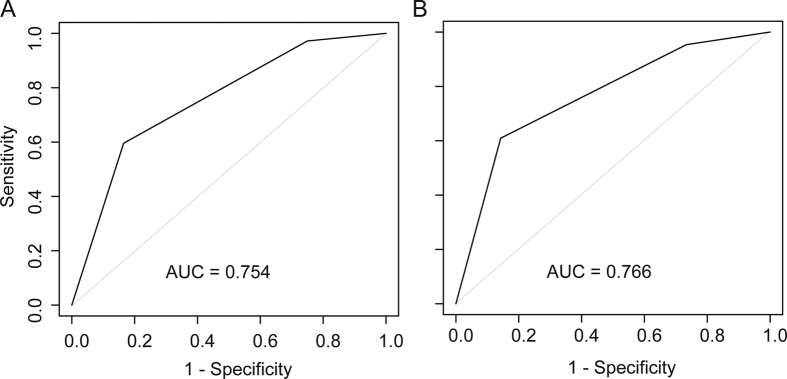
Time-dependent receiver operating characteristic (ROC) curves of evaluated patients with cervical cancer from both the (A) training study and the (B) validation cohort. ROC curves for the risk model were used as predictors of recurrence as result of cervical cancer within 5 years in the (A) training study and (B) validation cohort. The areas under the ROC curves were >0.75 in both the training study and the validation cohort.